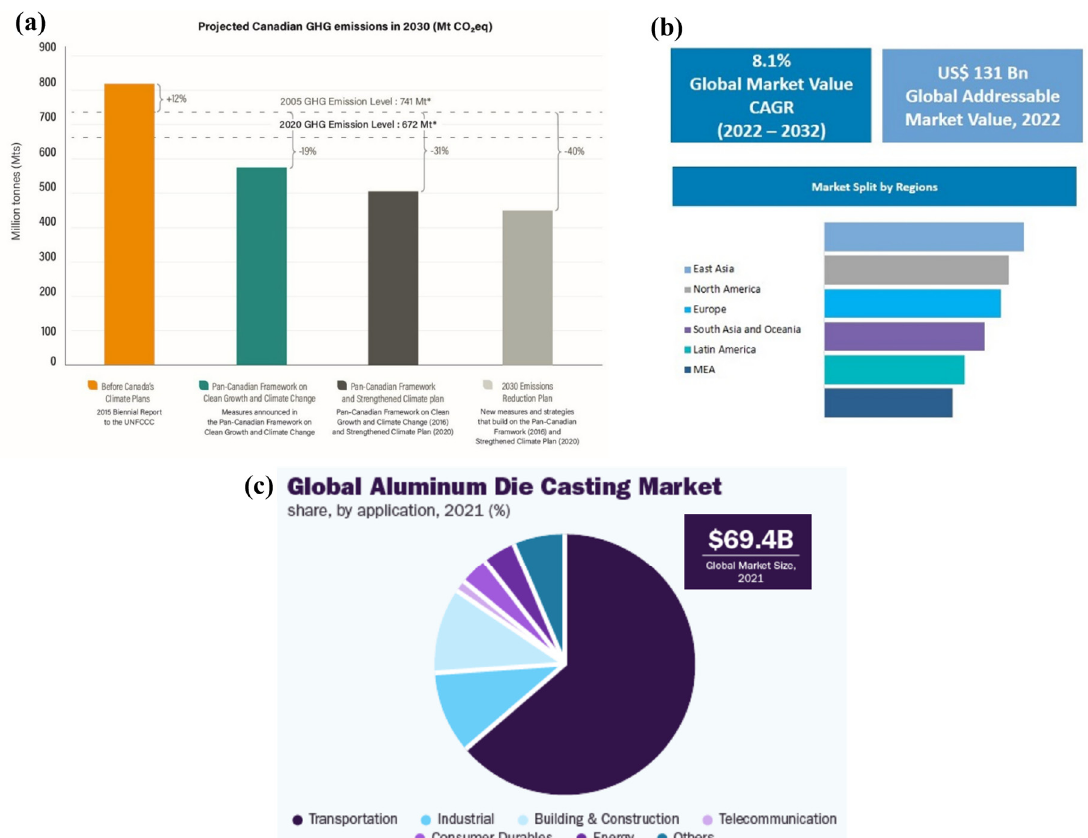
Figure 1. ( a ) Projected Canadian GHG emissions in 2030 in terms of CO 2 equivalent [3]. ( b ) Global Al alloy market value split by regions from 2022 − 2032 [11]. ( c ) Global Al die − casting market share by application [9]. Reproduced with permission from open-access